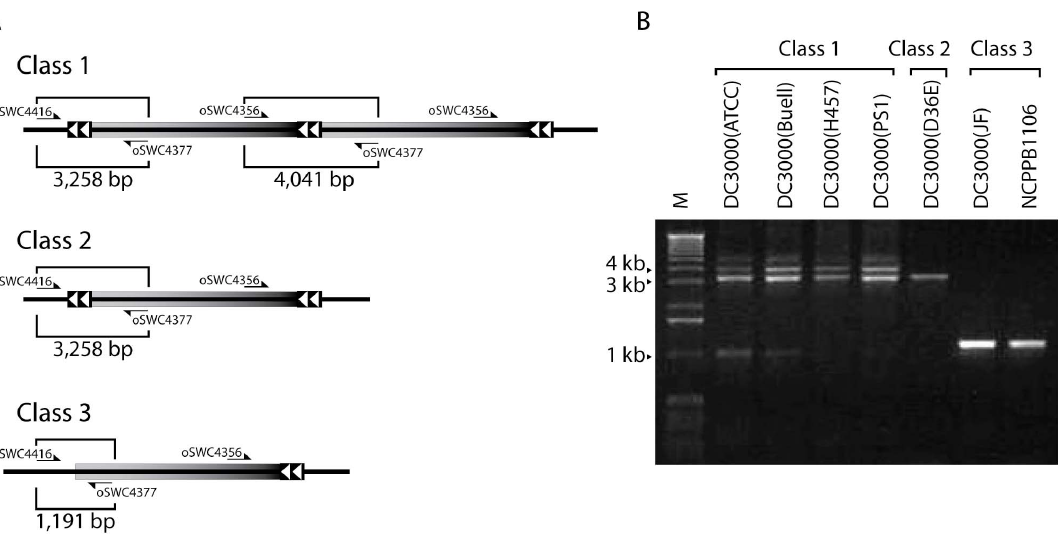
Figure 4. Multiplex PCR demonstrates allelic variation at the 165 kb duplication locus. Three primers (oSWC4416, oSWC4356 and oSWC4377) were used in PCRs with different Pst isolates as template. A. Multiplex reactions can distinguish three classes of genetic architecture at the 165 kb duplication locus. Class 1 has the full 165 kb tandem duplication; Class 2 does not have the duplication, but has the pair of ISPsy5 elements framing the 165 kb region; Class 3 does not have the duplication or the ISPsy5 on the left flank of the 165 kb region. B. PCRs resolved on 1% agarose gels show products representing the three varieties of alleles. The genomic DNA used as template in PCRs is shown above each lane. DC3000(Buell) indicates PCR using Pst DC3000 genomic DNA that was prepared for the genome sequencing reported in Buell et al., 2003 [29]. All other strains are listed in Table 1. M, molecular weight marker. PCR using oSWC4416 and oSWC4377 occasionally generated minor 1 kb product, as seen in Pst DC3000(ATCC) and Pst DC3000(Buell). The band was extracted from the gel and sequenced. BLAST analysis indicated that the minor product corresponded to coordinates 4978742..4979422 in the Pst DC3000 genome sequence. This region is more than 22 kb downstream from the 165 kb duplicated region and most likely formed as a result of mis-priming.